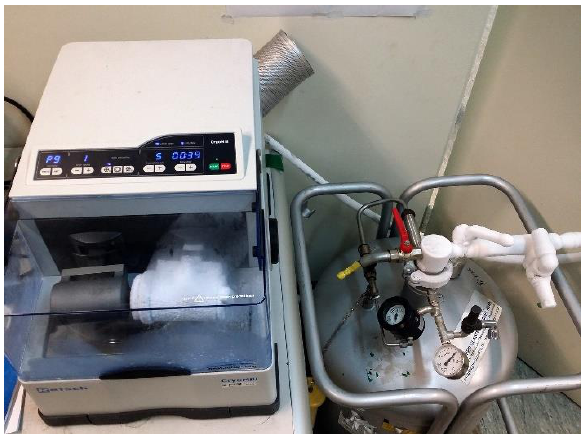
Figure 35. A Cryo-milling equipment housed at